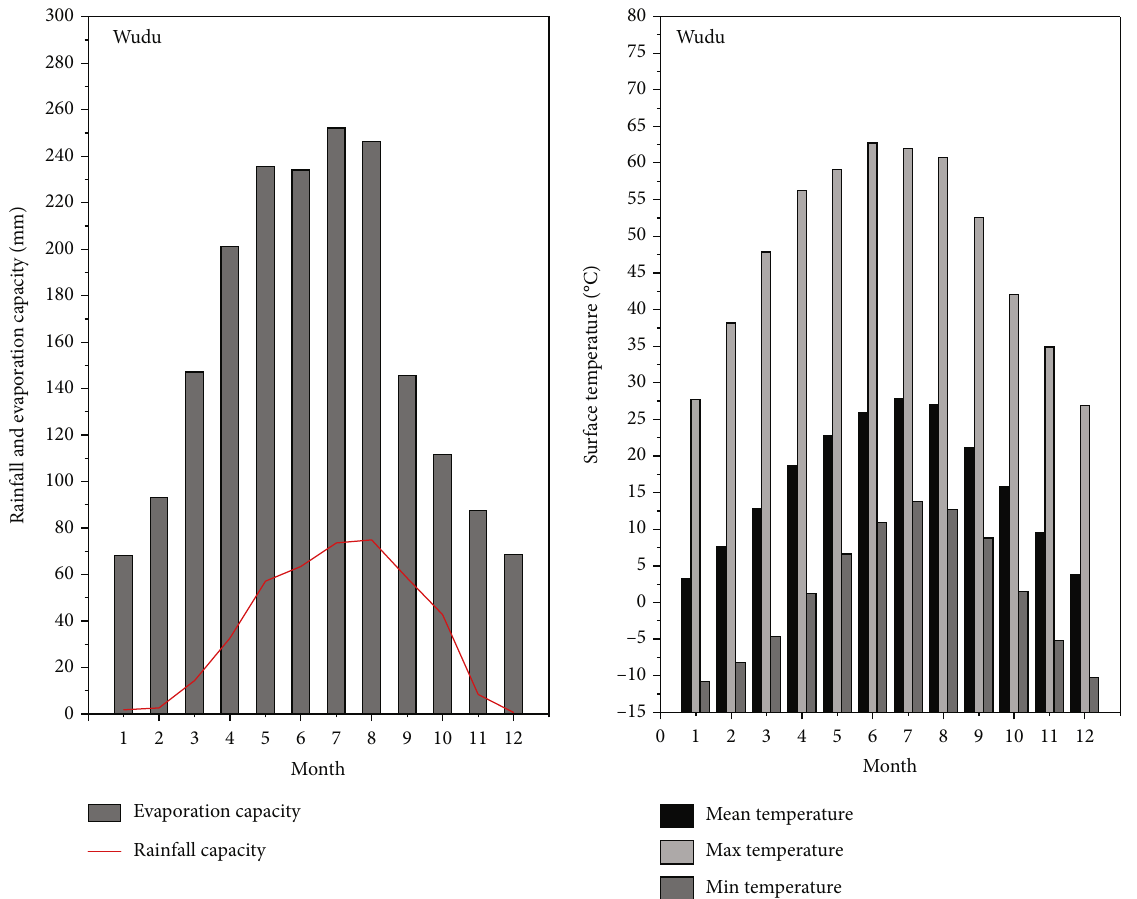
Figure 3: Monthly evaporation and precipitation capacity in Wudu.